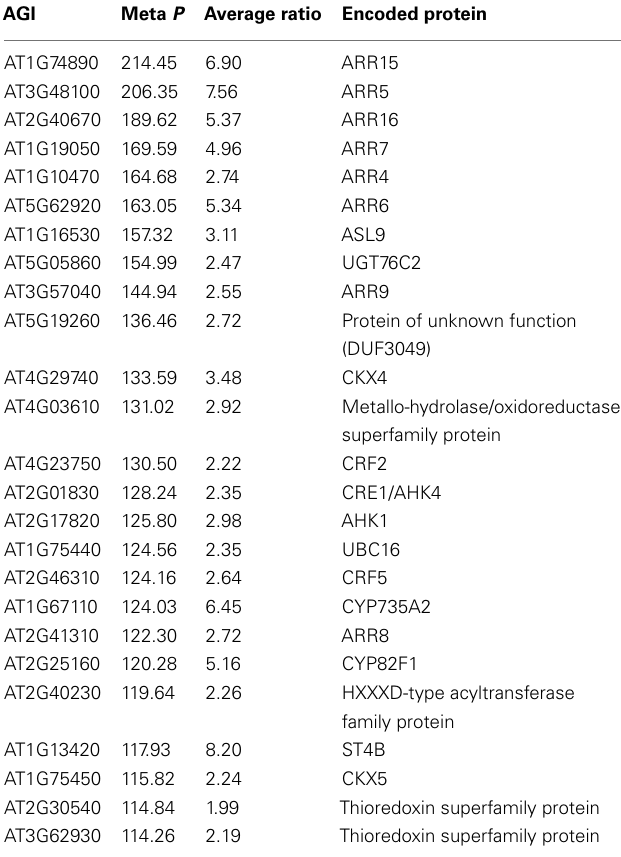
Table 3 |Top 25 genes of a meta analysis across selected transcript profiling experiments of Arabidopsis thaliana performed with AffymetrixATH1